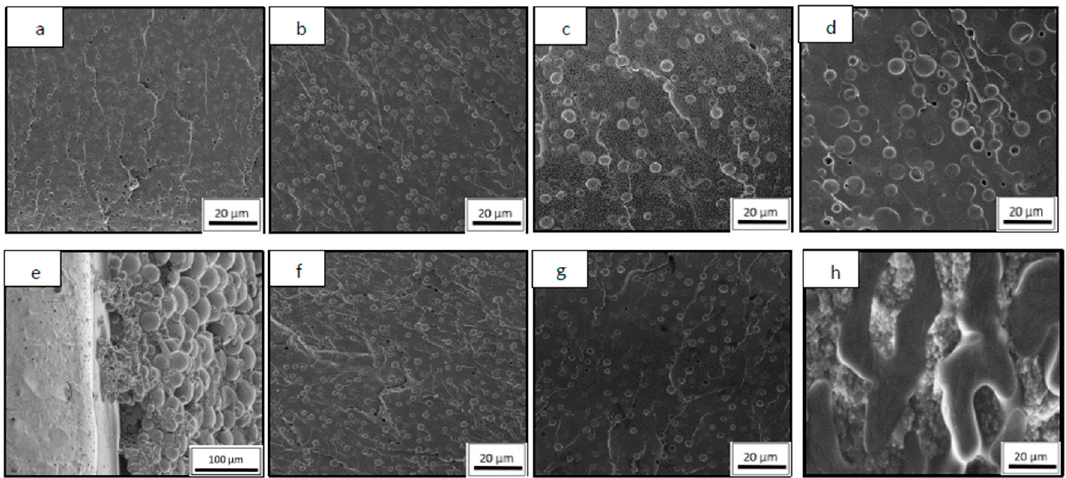
Figure 1. SEM images of PCL / epoxy blends: DGEBA / TETA resin modified with 10 ( a ), 15 ( b ), 20 ( c ), 25 ( d ), and 30 wt % PCL ( e ) and DGEBA / DDS resin with 10 ( f ), 15 ( g ), and 20 wt % PCL ( h ).